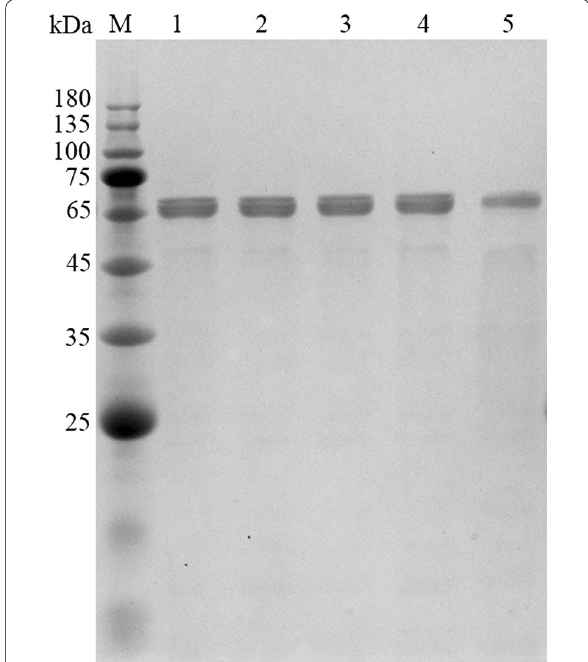
Fig. 1 SDS-PAGE analysis of the purified recombinant Ts POx and its mutants. M, the molecular mass marker; lane 1, the wide-type; lane 2, the mutant K312E; lane 3, the mutant E539K; lane 4, the mutant T166A/E539K; and lane 5, the mutant